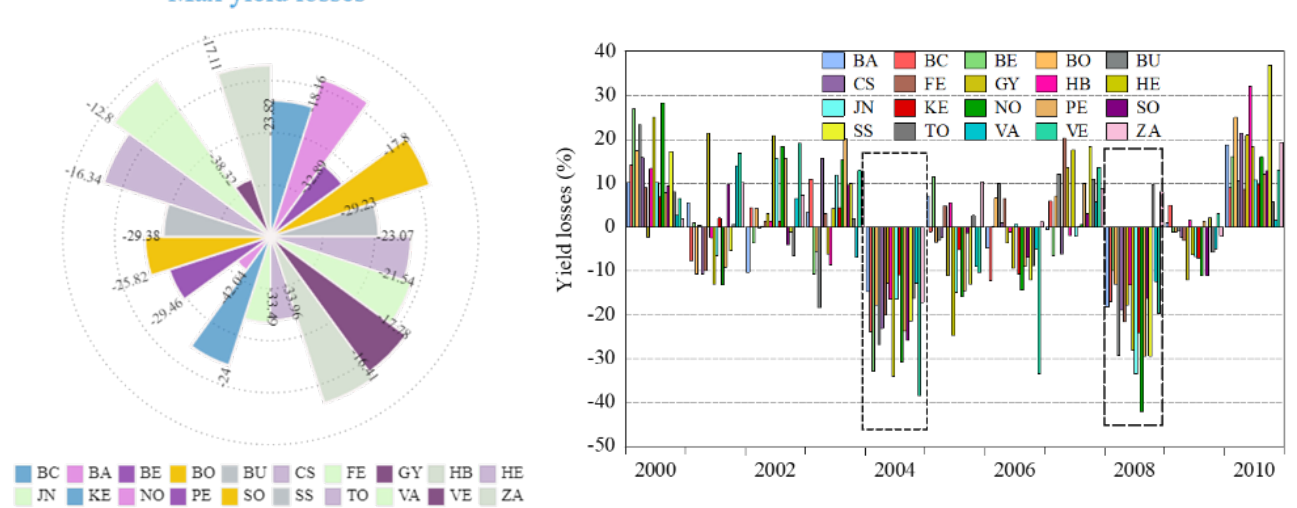
Figure 9. Sunflower resilience to Ag.D (SRAg.D) ( right ), and max yield losses ( left ). By calculating the SRAg.D, the resistance of sunflower crops to drought events could be distinguished across Hungarian counties (Figure 10). The results showed that the crop yields in central and western regions were more prone to loss due to drought events. The SRAg.D value reached 0.74 (severely non-SRAg.D) in HE, and 0.79 (also severely non- SRAg.D) in PE. In contrast, the highest value was recorded in eastern Hungary (BE; 1.11).